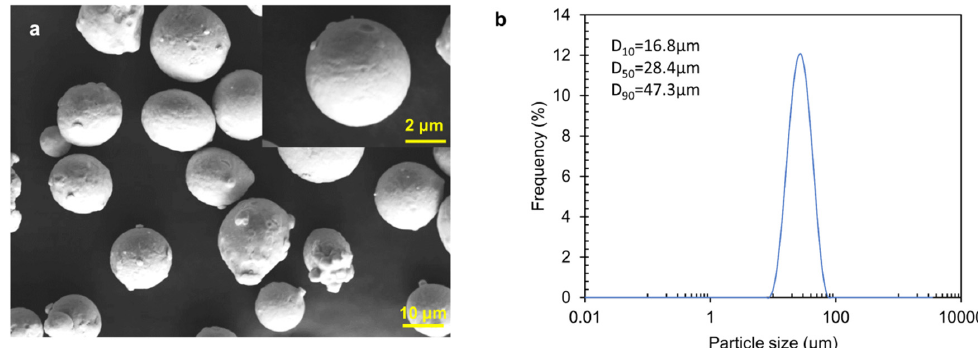
Figure 1. ( a ) SEM micrograph showing the micrograph of H13 powders; ( b ) distribution of particle sizes.